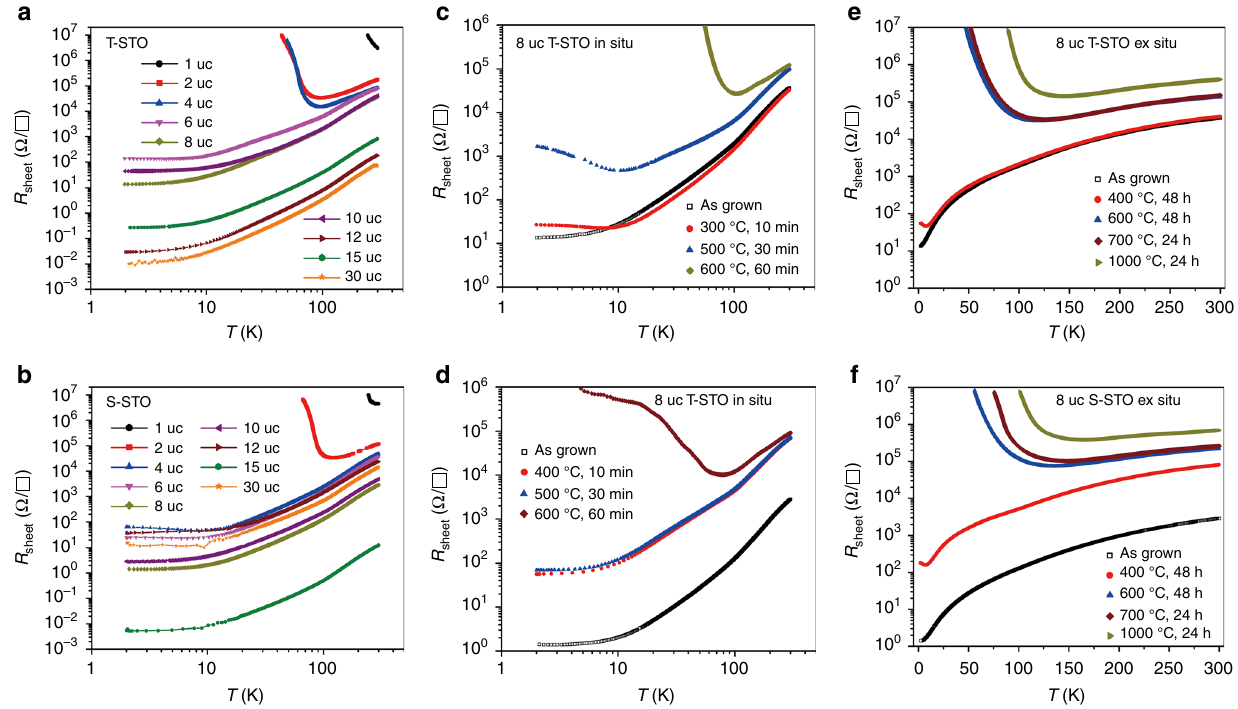
Fig. 2 Electrical transport properties of CaHfO 3 /SrTiO 3 (CHO/STO) heterointerfaces. a , b Temperature dependence of R sheet for the as-grown CHO of various thicknesses grown on TiO 2 -terminated STO (T-STO) and SrO-terminated STO (S-STO), respectively. The same samples were post-annealed ex situ in O 2 , and the corresponding results are shown in Supplementary Fig. 6. c , d Temperature dependence of R sheet for the in situ annealed CHO (8 uc) grown on T-STO and S-STO, respectively. Each curve represents a sample that has been annealed in situ under P (O 2 ) = 200 mbar, at the conditions as labeled. More in situ annealing results on samples of different thicknesses are presented in Supplementary Fig. 7. e , f Temperature dependence of R sheet for the ex situ annealed CHO (8 uc) grown on T-STO and S-STO, respectively. In each case, one as-grown sample was annealed ex situ subsequently from low to high annealing temperature, under P (O 2 ) = 1 bar, in a tube furnace. For clarity, double-logarithmic coordinates were used in a – d , and semi-logarithmic coordinates were used in e , f